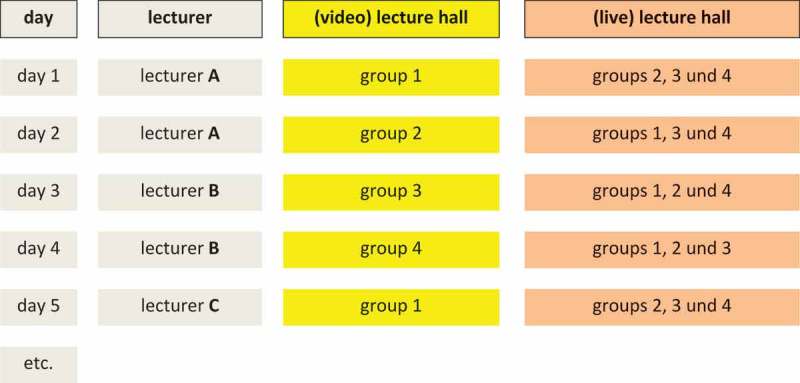
Crossover setting.